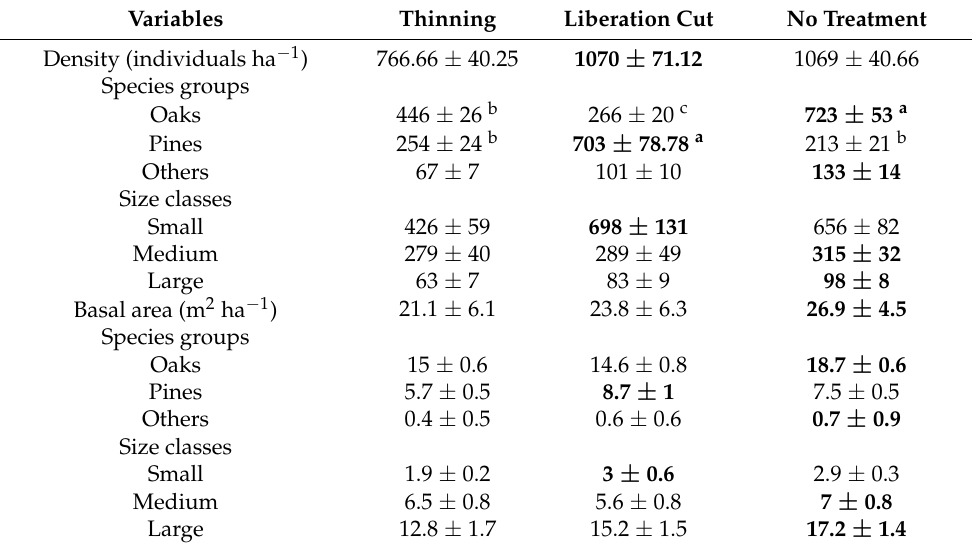
Table 2. Tree density (No. ind. ha − 1 ) and basal area of trees (DBH > 5 cm) in three silvicultural treatments in southeastern Mexico. Average values ± standard errors are shown for each variable, per species group and size class. Different letters indicate significant differences in each row (GLM and Tukey post hoc test p < 0.05). The highest values per species group and size class in each treatment are shown in bold font. Variables Thinning Liberation Cut No Treatment Density (individuals ha − 1 ) 766.66 ±